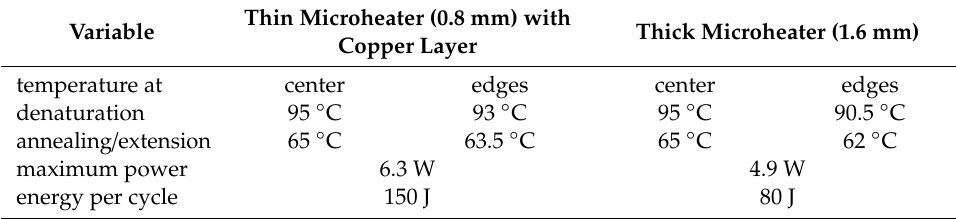
Table 2. Temperature profile across the PCB chips and power consumption.